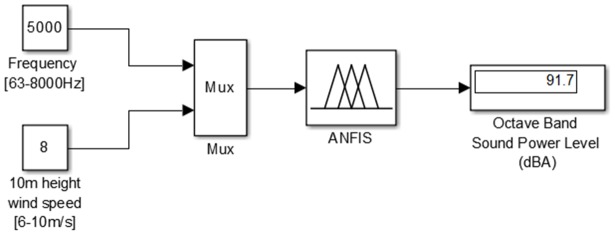
Simulink block diagram for estimation of sound power level of wind turbines.